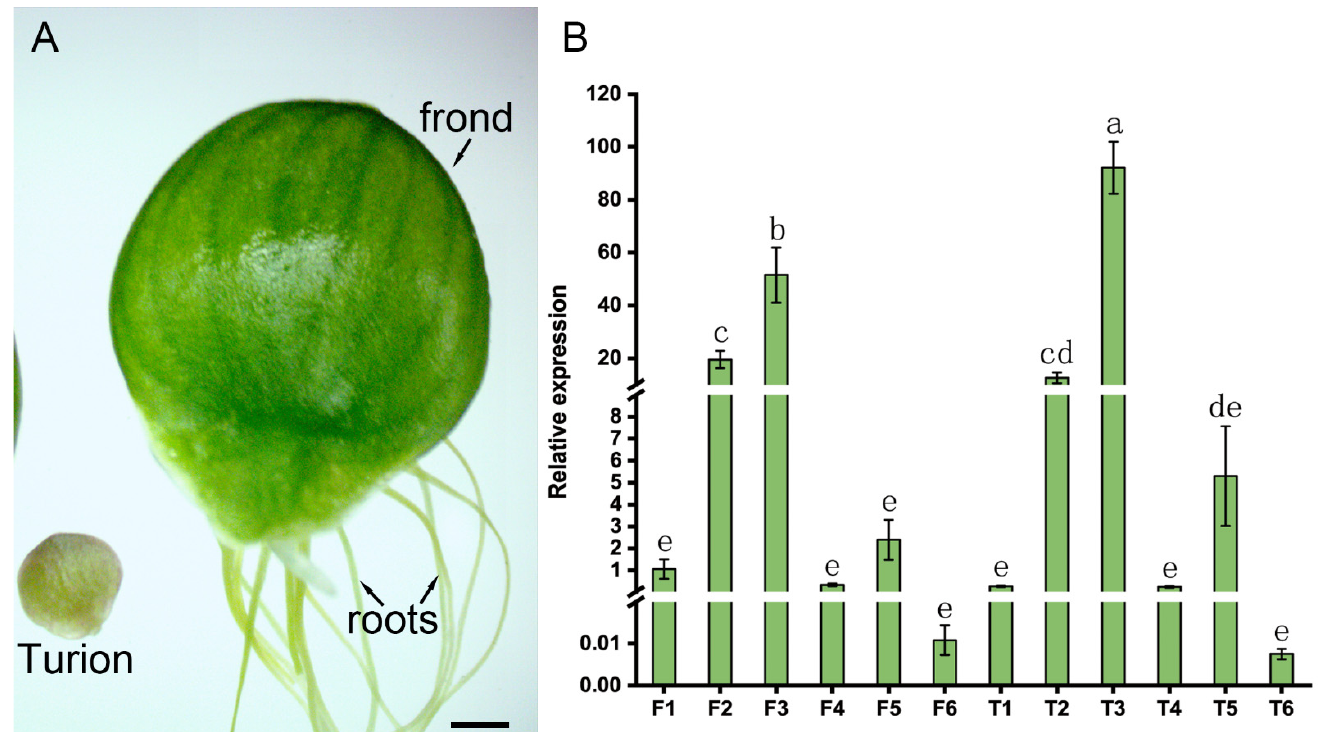
Figure 8. Phenotypes and expression of the SpGRFs in the frond and turion of S. polyrhiza . ( A ) Phenotypes of turion (left) and whole plant (right) of S. polyrhiza . Bar = 1 mm. Arrows indicate frond or roots of S. polyrhiza , separately. ( B ) Expression of the SpGRFs in the frond and turion. F1: SpGRF1 in the frond; F2: SpGRF2 in the frond; F3: SpGRF3 in the frond; F4: SpGRF4 in the frond; F5: SpGRF5 in the frond; F6: SpGRF6 in the frond; T1: SpGRF1 in the turion; T2: SpGRF2 in the turion; T3: SpGRF3 in the turion; T4: SpGRF4 in the turion; T5: SpGRF5 in the turion; T6: SpGRF6 in the turion. The different letters indicate statistically significant differences relative to F1, as determined by the Duncan test ( p < 0.05).